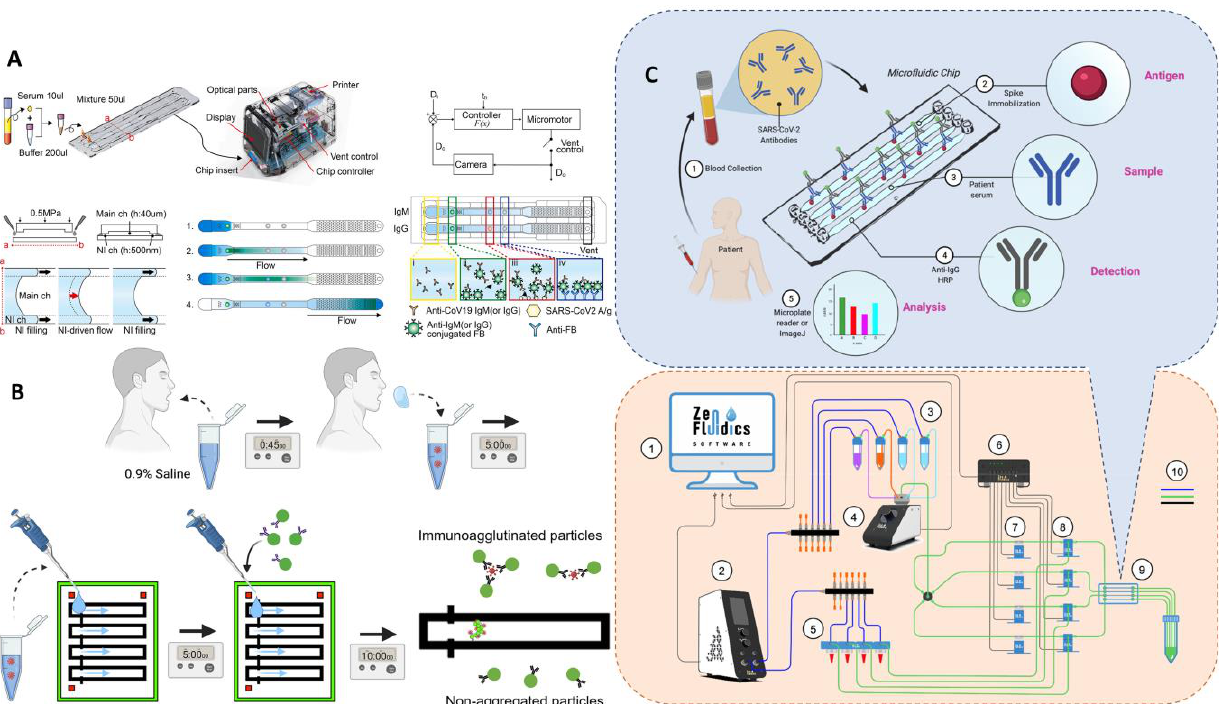
Figure 10. Microfluidic laboratory based on labeled immunoassay. ( A ) The assay progress of SARS-CoV-2 detection from clinical saline gargle samples. Reproduced with permission from Bres- hears, L. E., PNAS Nexus , published by Oxford Academic, 2022 [72]. ( B ) Schematic diagram of the microfluidic quantitative detection of SARS-CoV-2. Reproduced with permission from Lee, J. H., Biosens. Bioelectron. , published by Elsevier, 2021 [75]. ( C ) Schematic of automated ELISA on-chip for the detection of anti-SARS-CoV-2 antibodies. Lower right corner: (1) software to control all devices; (2) flow control unit; (3) ELISA reagents; (4) 12/1 bidirectional microfluidic rotary valve; (5) serum samples; (6) microfluidic valve controller; (7) pinch valves; (8) 3/2-way switching valves; (9) microfluidic device; and (10) connections between components and reservoirs (color code: blue is for pneumatic connections, green is for fluid connections, and black is for electrical connections). Reproduced with permission from Gonzalez-Gonzalez, E., Sensors , published by MDPI, 2021 [78].